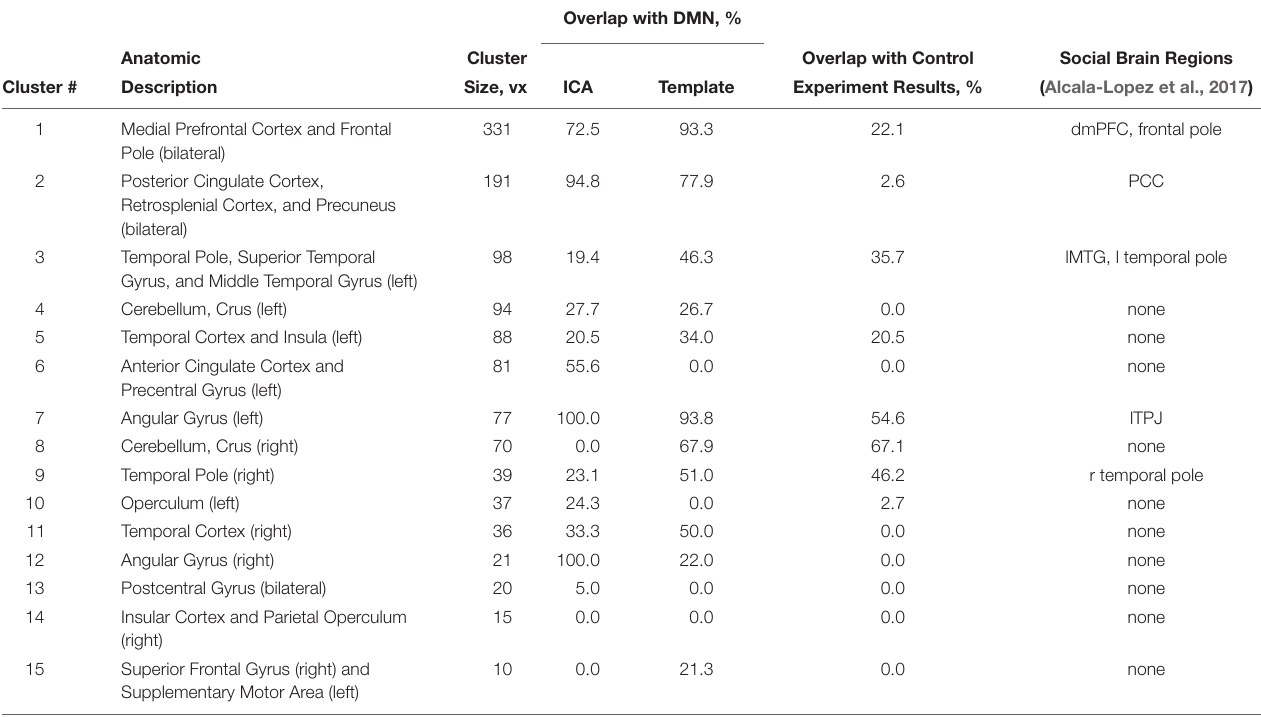
TABLE 1 | Regions of greater activation in group compared to individual problem solving: Overlap with the DMN, control experiment activation data, and social brain atlas.